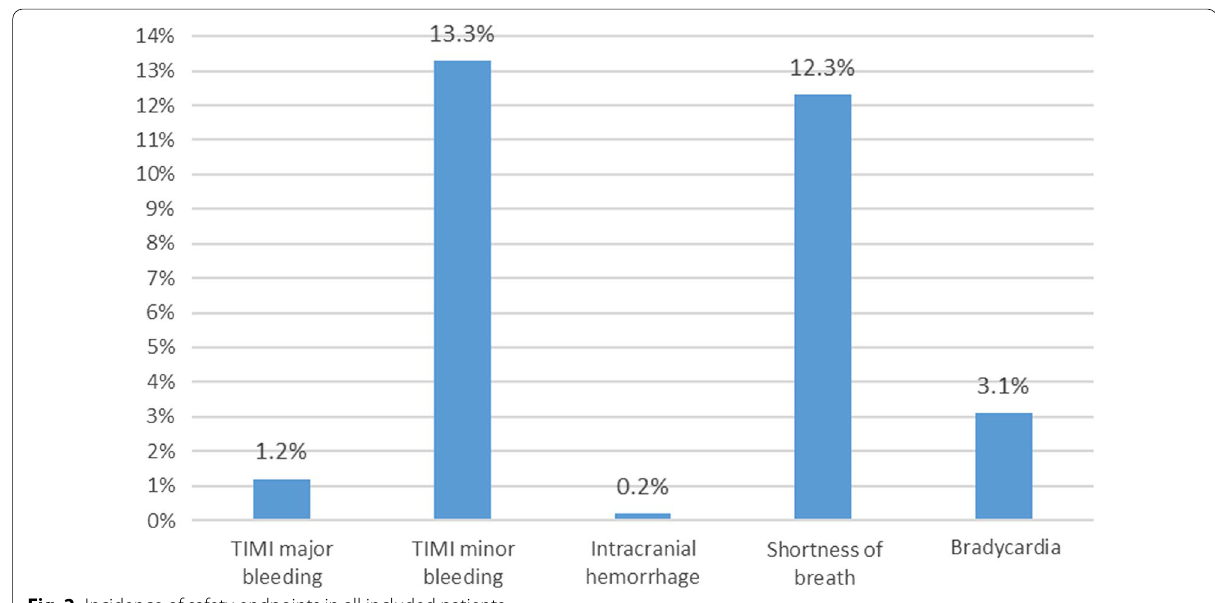
Fig. 2 Incidence of safety endpoints in all included